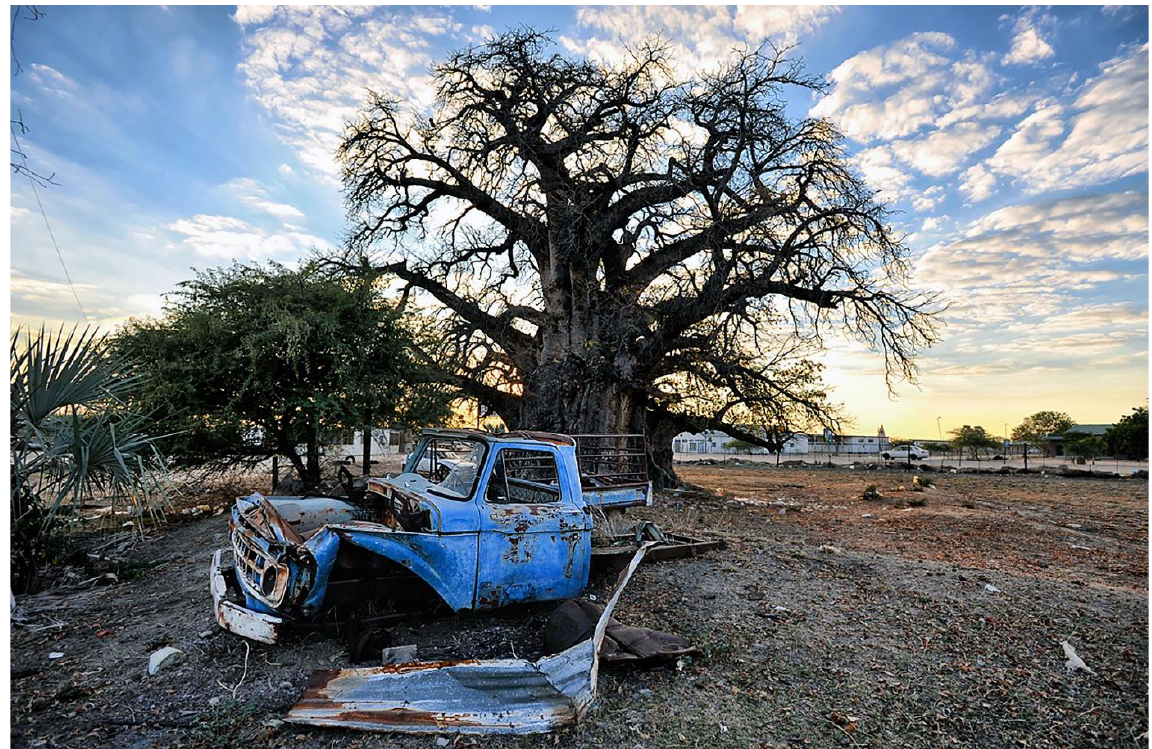
Figure 4. The Ombalantu baobab witnessed many violent events during the South African Border War. The photograph was taken in 1980.